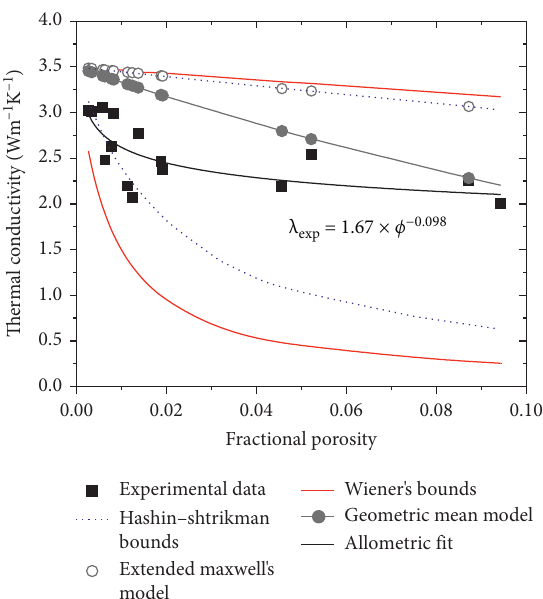
Figure 2: Comparison of experimental thermal conductivity with the values predicted by mixing law models along with Wiener’s and H-S